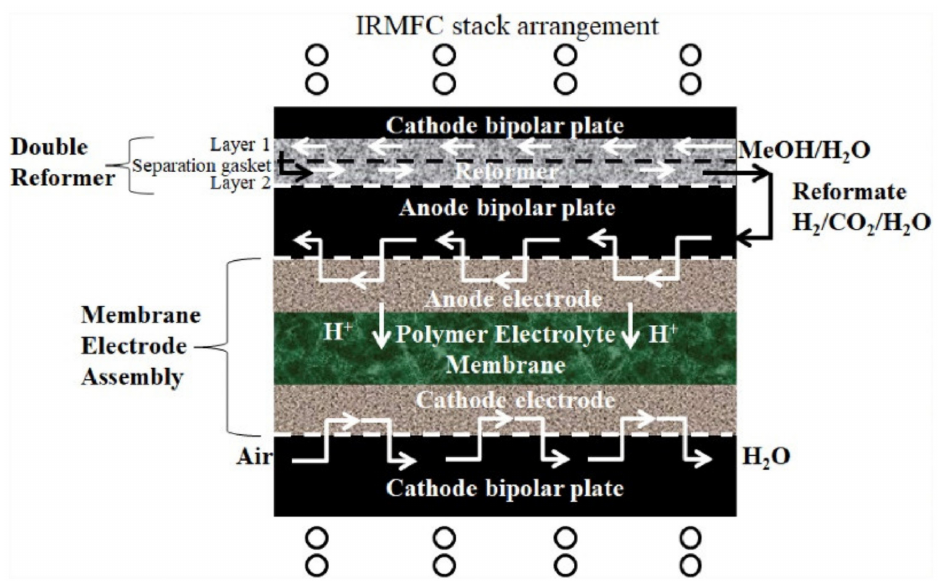
Figure 15. IRMFC configuration, employing the double methanol reformer arrangement. (Adapted from [48], copyright 2019,